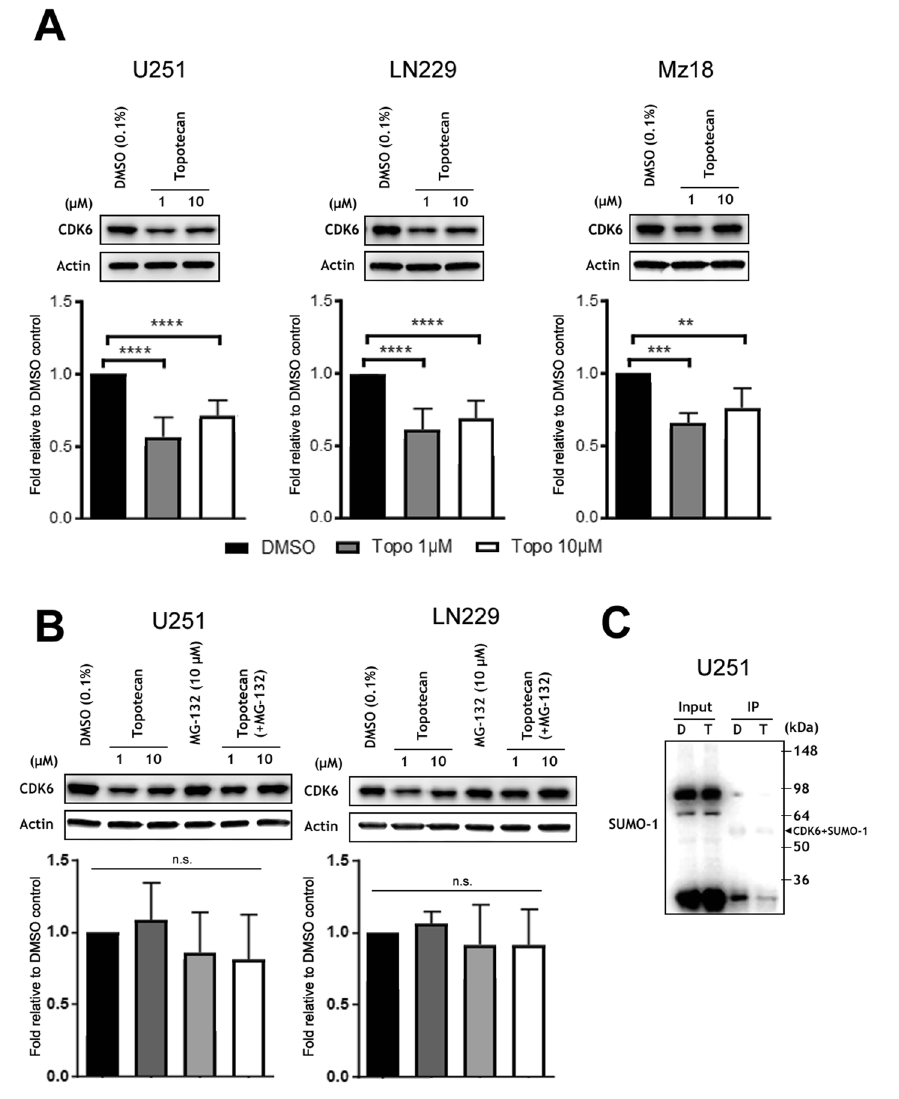
Figure 4. Topotecan alters CDK6 levels in GBM lines. ( A ) Topotecan causes a decrease in CDK6 protein levels in GBM lines U251, LN229, and Mz18 at concentrations of 1 μ M and 10 μ M. ( B ) The addition of MG132, a specific inhibitor of the protease activity of the 26S complex, attenuates the decrease in CDK6 protein levels previously seen in lines U251 and LN229. Representative immunoblots are shown. The band corresponding to CDK6 (40 kDa) was cropped in each lane and the total intensities were measured. Densities were normalized to corresponding actin levels and expressed as a fold difference relative to the control (DMSO). Data are means ( ± SD) from n = 5 independent experiments. ** p ≤ 0.01, *** p ≤ 0.001, **** p ≤ 0.0001 vs . DMSO. ( C ) Lysates from U251 cells treated either with DMSO or topotecan at 1 μ M for 12hr were immunoprecipitated using an anti-CDK6 antibody followed by immunoblotting using an anti-SUMO-1 antibody. Arrow highlights the predicted CDK6-SUMO-1